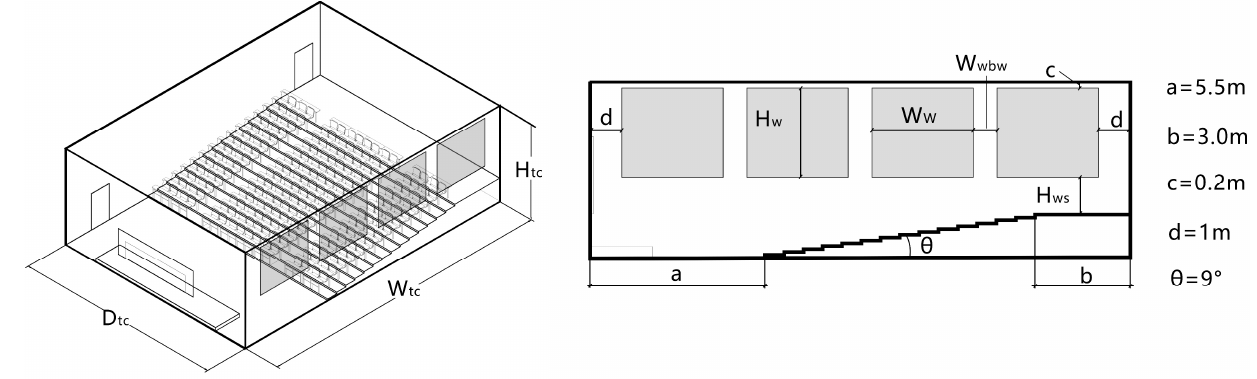
Figure 4. The geometric parameter information of simulation models.